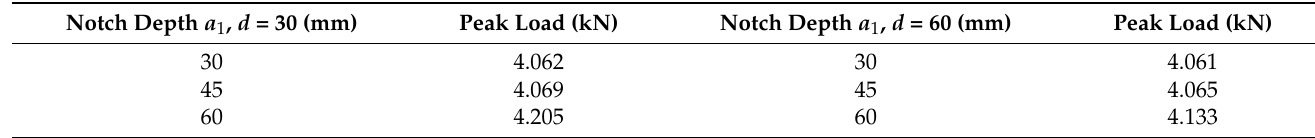
Table 3. Predicted peak loads of double-notched concrete beams with different d (30 mm, 60 mm) and a 1 (30 mm, 45 mm, 60 mm)